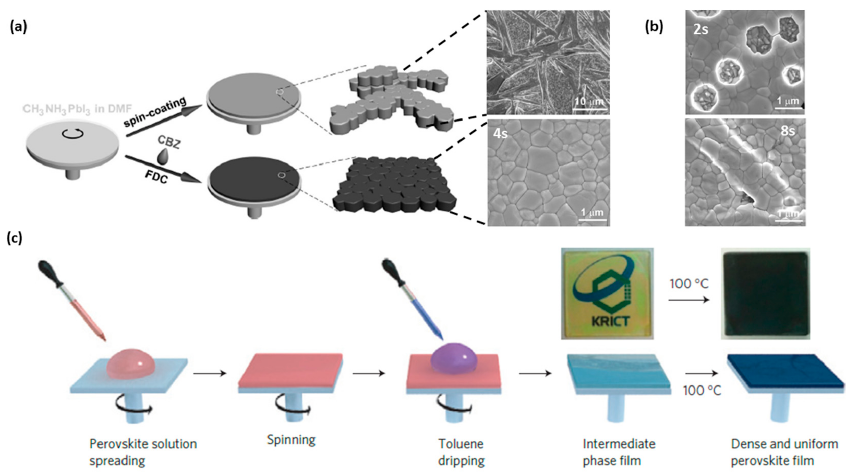
Figure 2. ( a ) Schematic illustration of anti-solvent dripping (denoted as FDC) and conventional spin-coating process for fabricating perovskite films. Conventional spin-coating (top) results in a gray film (on top of a compact TiO 2 layer) composed of rod-like crystals. In the FDC process (bottom), a light brown film is formed, consisting of uniformly sized perovskite grains. ( b ) SEM images of the surface morphology of films prepared by adding CBZ at different delay times from the start of the spin-coating process (after 2 s and 8 s) Note that a delay time between 4 and 6 s produces the optimum morphology. Reproduced from Ref. [7] with permission from Wiley-VCH. ( c ) Toluene dripping during precursor perovskite solution (gBL-DMSO) spin-casting onto m-TiO 2 substrate for preparing a stable intermediate which easily transforms into the perovskite after annealing. Reproduced from ref. [8] with permission from Nature Publishing